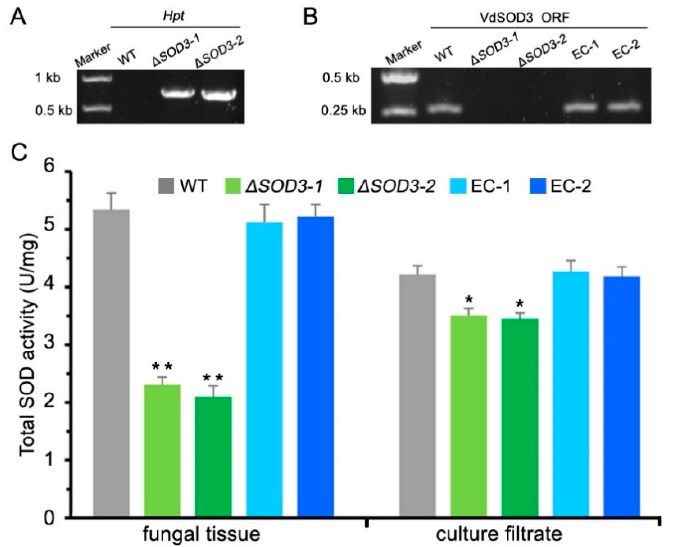
Figure 4. VdSOD3 contributes to both fungal intra- and extracellular SOD activity upon Verticillium dahliae entering the stationary phase. ( A ) Detection of the positive targeted VdSOD3 deletion strains by detection of the Hpt fragment. ( B ) Detection of the positive targeted VdSOD3 deletion strains and complementation strains by amplifying a VdSOD3 internal fragment. ( C ) Total superoxide dismutase activities of fungal tissue and extracellular culture filtrate of indicated strains collected from 7-day-old culture. SOD activities were determined by the nitroblue tetrazolium (NBT) reduction method. Error bars represent standard deviations ( n = 3). Asterisks ** and * represent significant differences p < 0.01 and p < 0.05 by Student’s t -test, respectively.